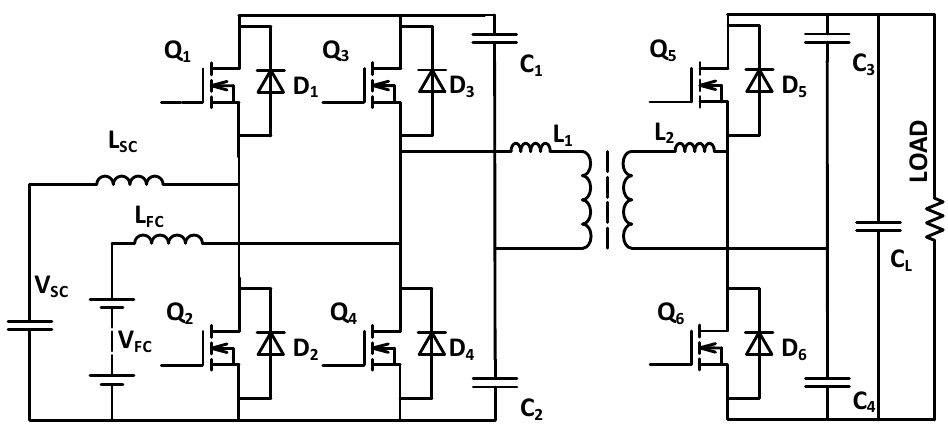
Figure 7. Topology of 3-port, 2-input boost multiport converter.